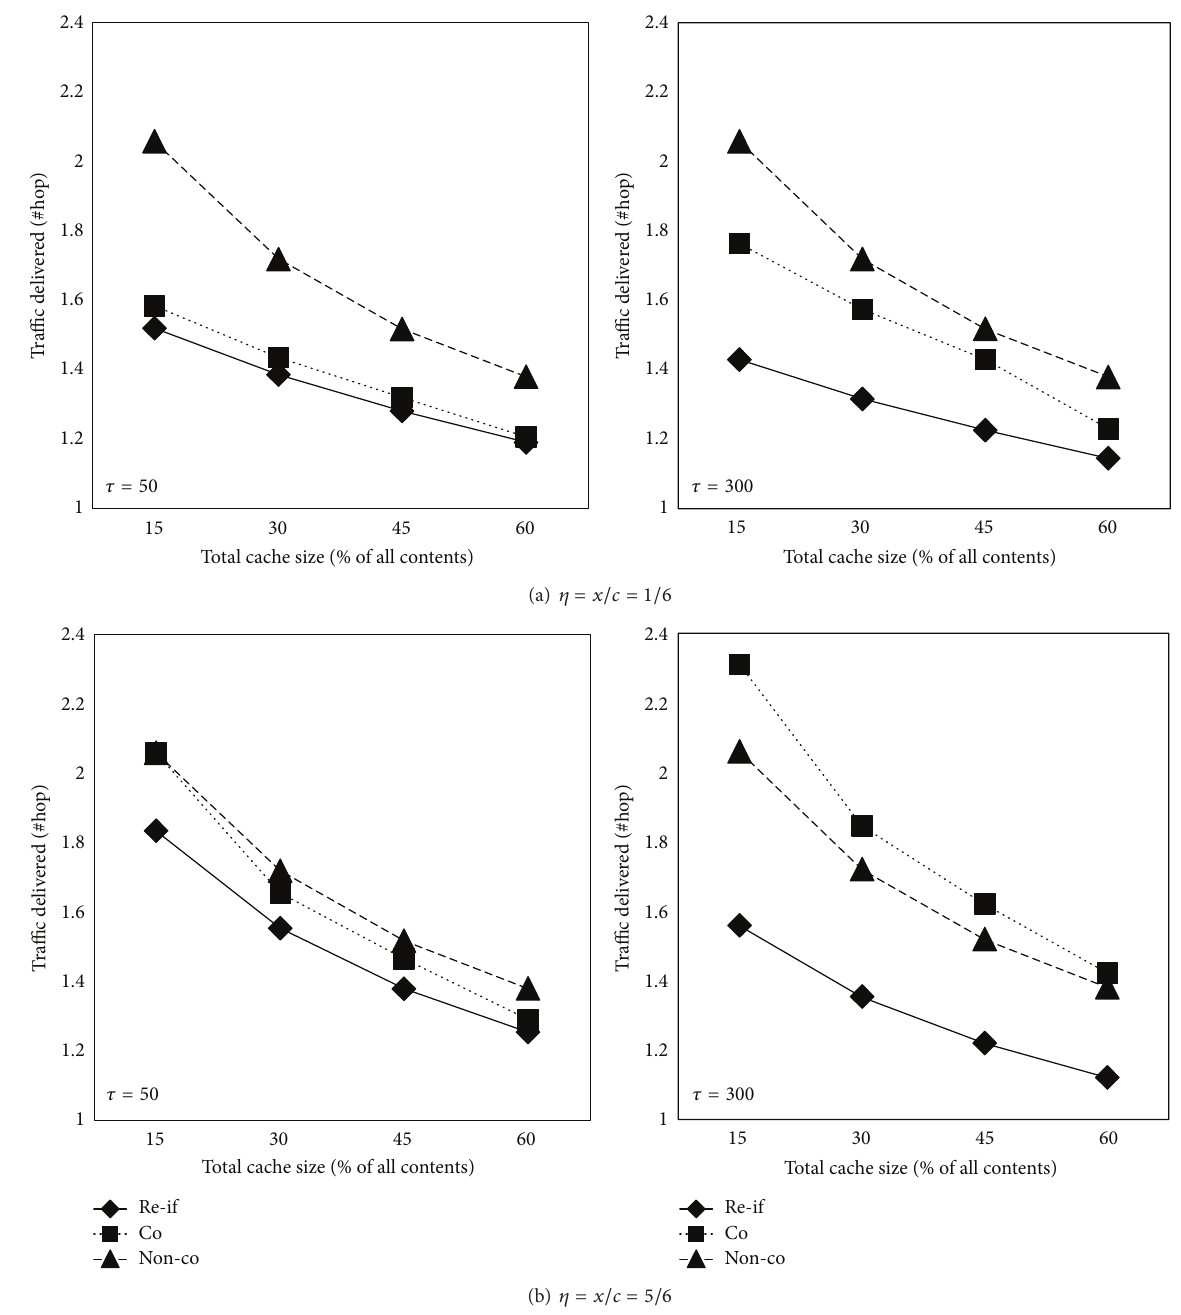
Figure 7: Traffic delivered versus cache